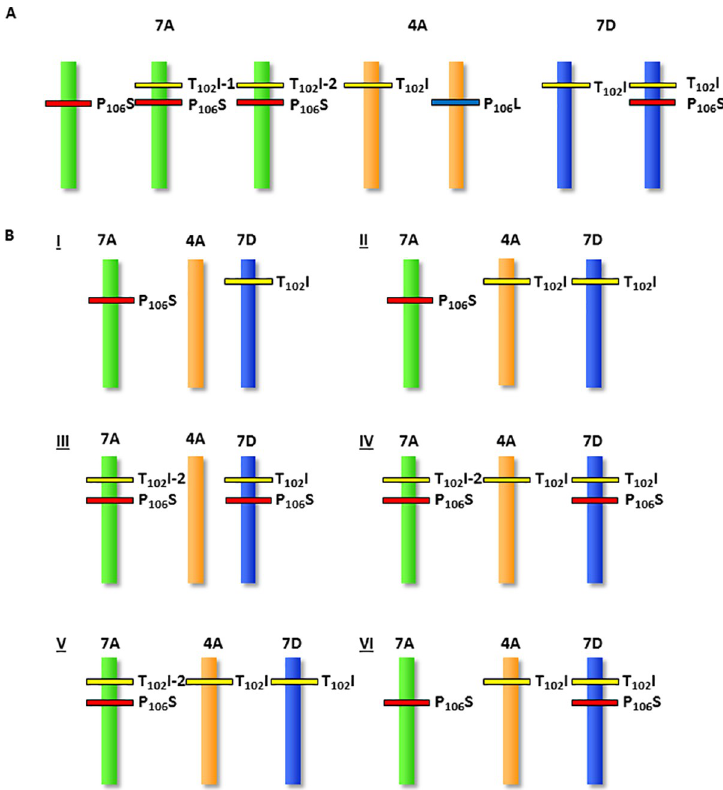
Fig 3. Schematic illustration of priority alleles identified and genetic constitution of lines created following conventional crosses. A. Priority alleles identified in the three targeted EPSPS homoeologs. The T 102 I allele on chromosome 7A was identified two independent times. B. Genetic constitution of wheat lines generated by conventional crosses. One chromosome is schematically illustrated but all lines are homozygous for the indicated alleles. (Not all possible genetic combinations are